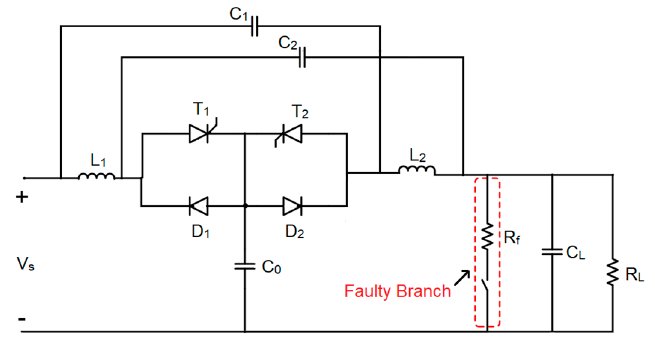
Figure 1. Components and circuit connection of intercross connected bidirectional Z-source circuit breaker (ICC-BZCB).